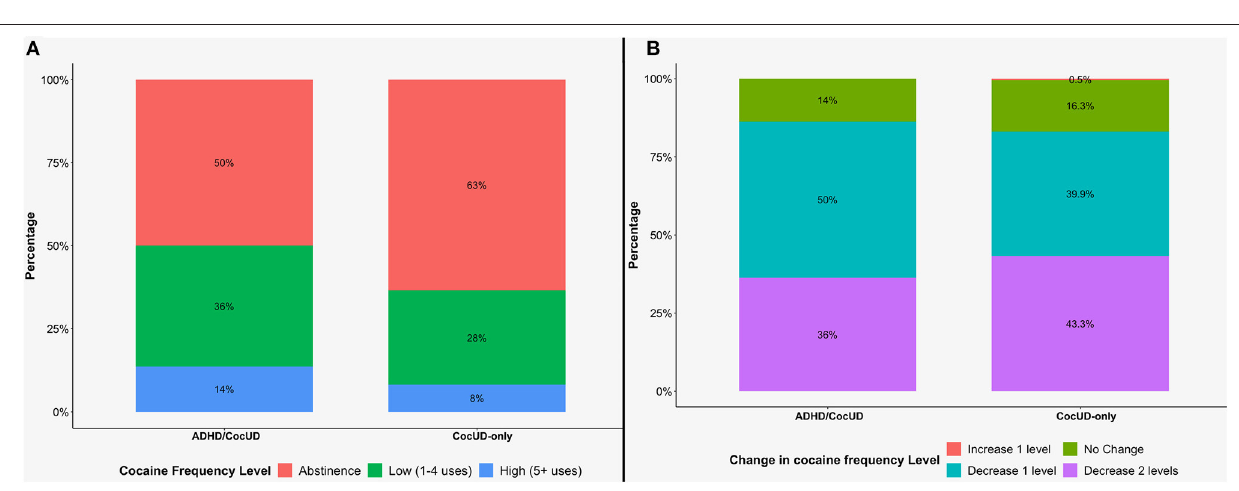
points. As previously observed, and here confirmed, at baseline groups were significantly different only for GSI scores [ t (566) = 3.03, adjusted p = 0.01]. After the first week of treatment both the groups significantly improved in all the scores, and pairwise comparison showed no significant differences for any of the clinical measures, neither at GSI [ t (566) = 2.37, adjusted p = 0.09]. At Day 30, pairwise comparison highlighted significant differences between groups for PSQI [ t (672) = 2.99, adjusted